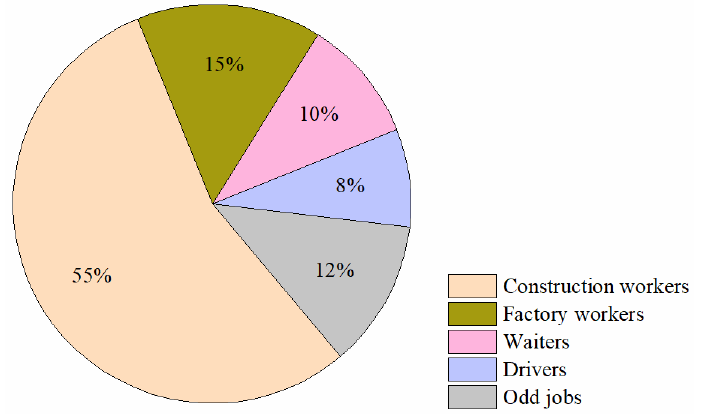
Figure 3. Types of work of migrant workers.